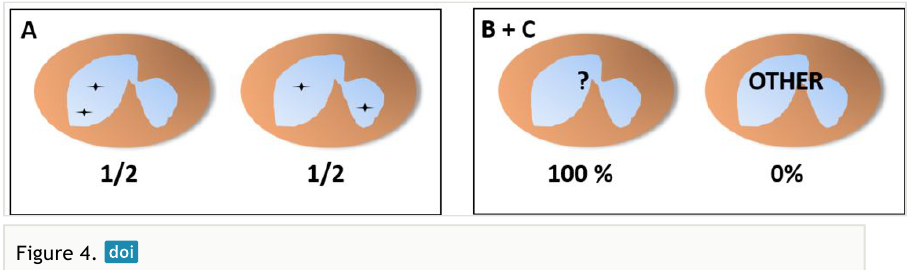
Figure 4. Probability of fi nding each distribution of the alleles in a basophil or eosinophil through the microscope, assuming an independent pattern (A, assuming an equal chance for both lobes), pattern of interdependent location independent of lobe (B) or pattern of interdependent location in a fi xed lobe (C). In cases B and C, since these cells only have two lobes, we would fi nd only cells with one of the distributions, so we would be unable to tell one of the patterns apart from the